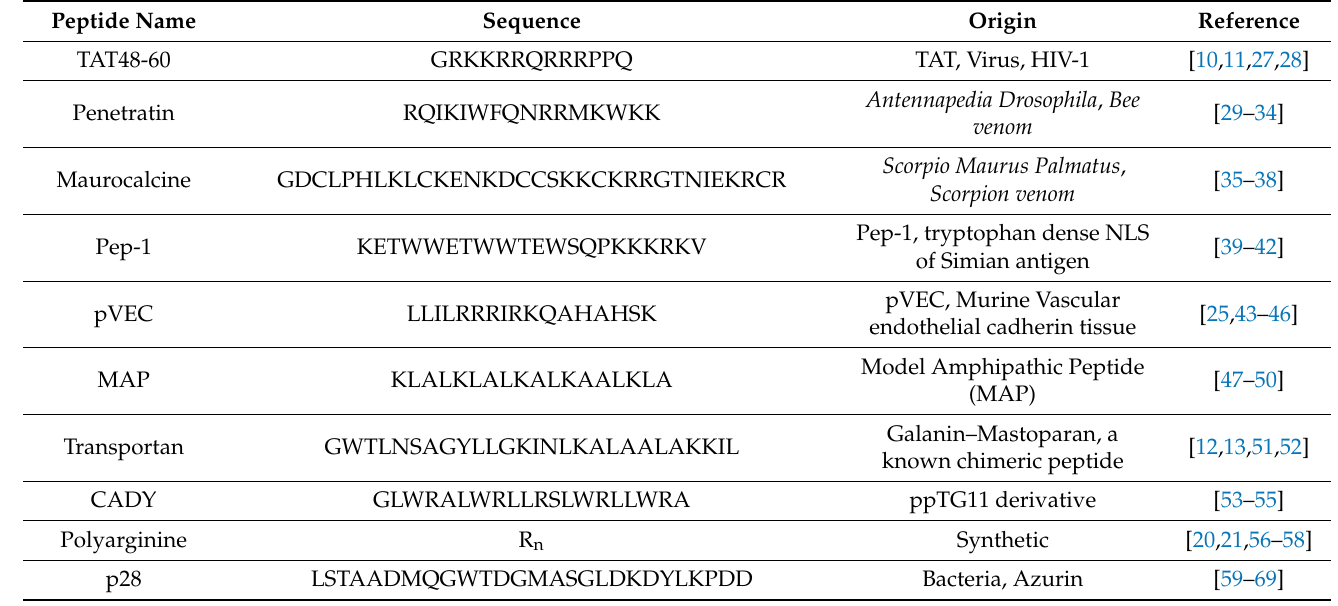
Table 1. Common CPPs from various sources and their